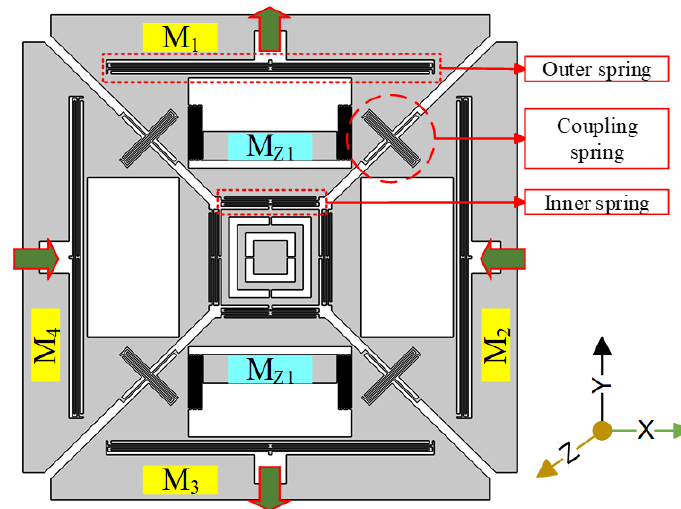
Figure 1. Mechanical structure of the proposed single-drive, 3-axis microelectromechanical systems (MEMS) gyroscope.